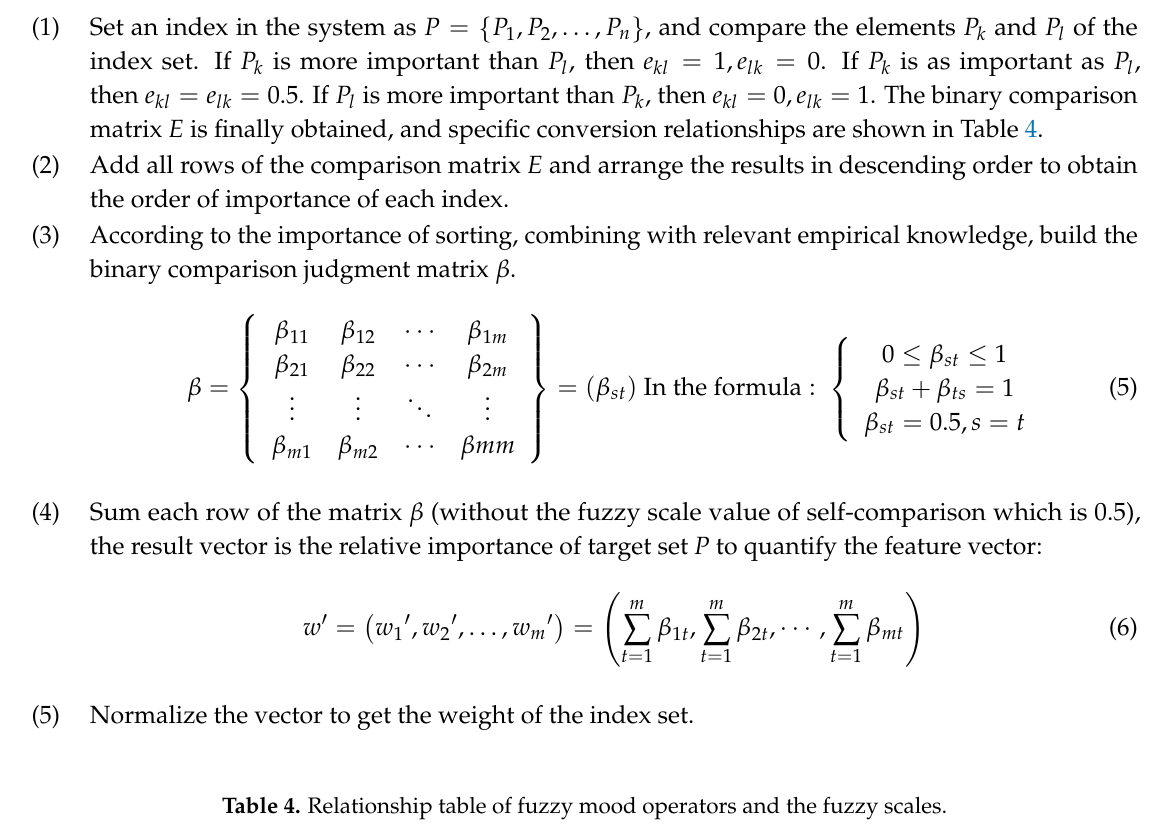
Table 4. Relationship table of fuzzy mood operators and the fuzzy